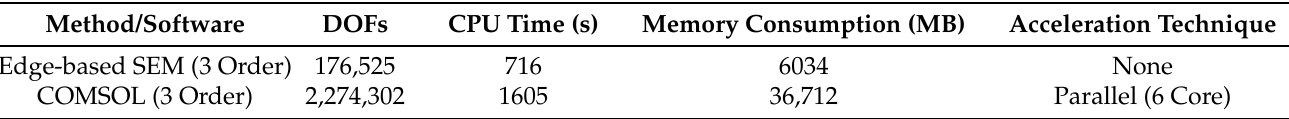
Table 1. Calculation statistics of edge-based SEM and